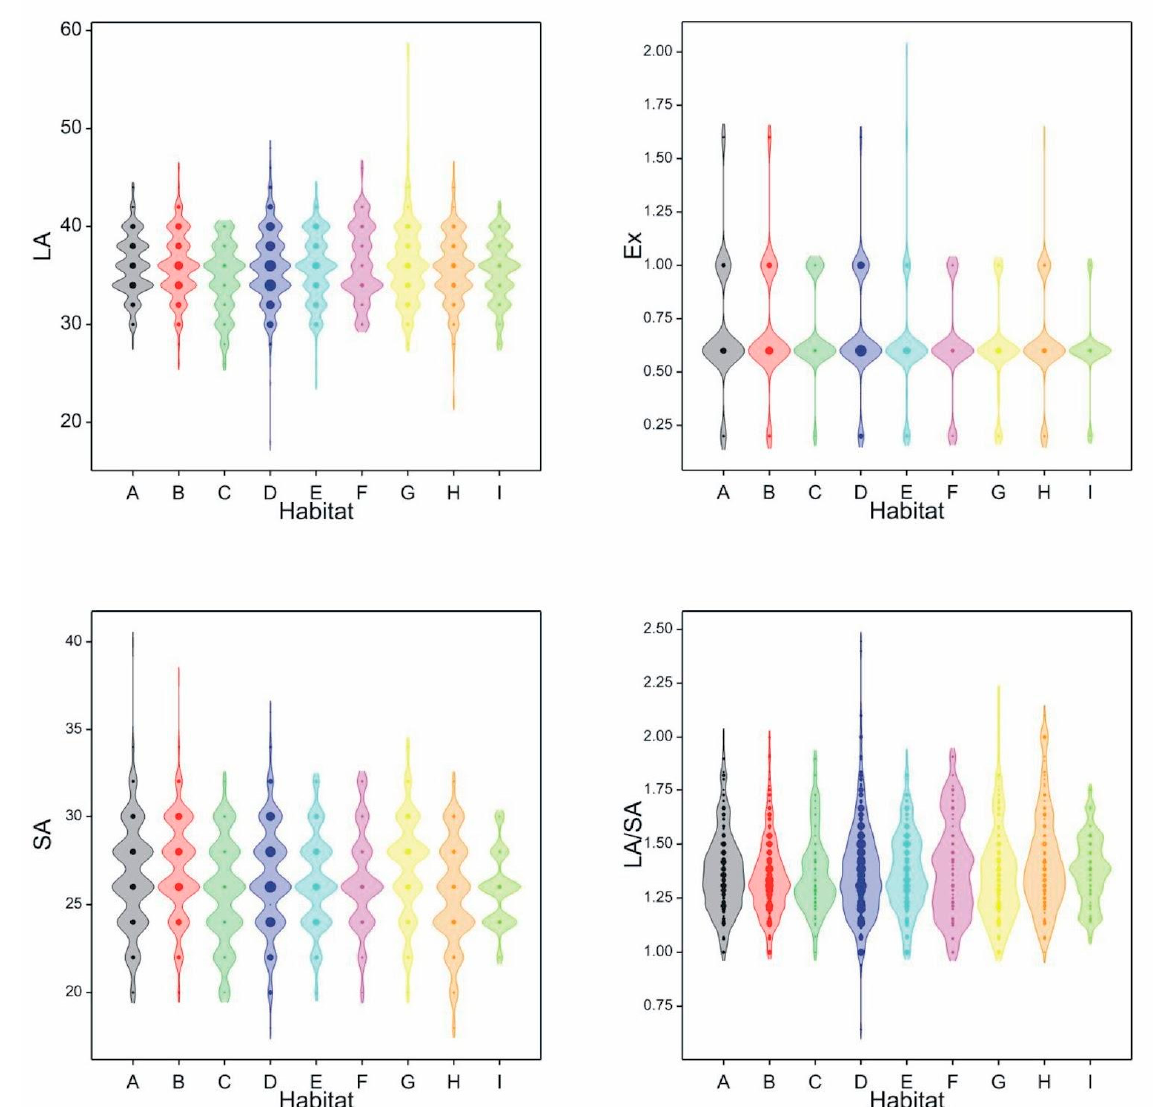
Figure 2. Density plots of the length of the longest polar axis (LA), exine thickness (Ex), length of the shortest polar axis (SA) and the LA/SA ratio, determined by habitats.